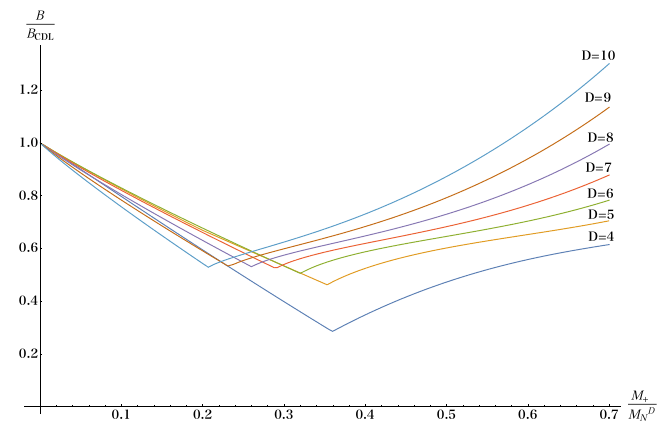
Figure 2 . Plots of the minimum bounce action in various dimensions as functions of M + =M ( D ) for (cid:12)xed (cid:17) = 0 :